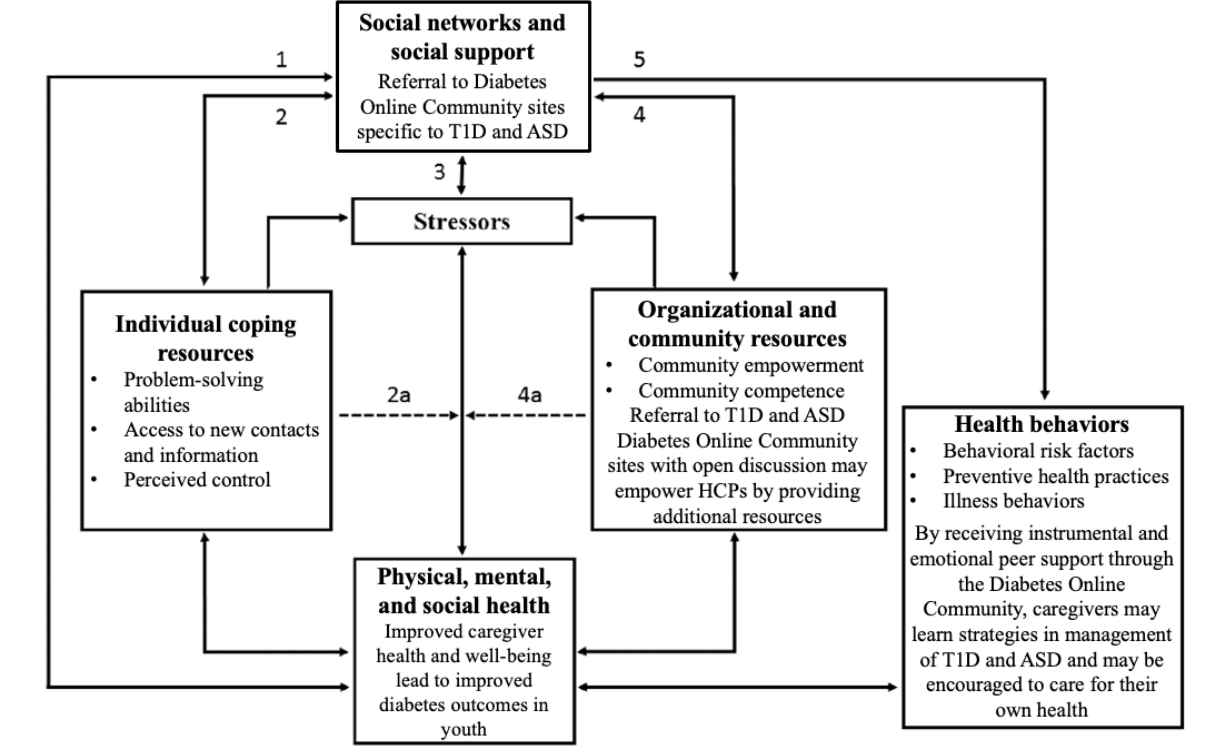
Figure 1. A modified conceptual model for the relationship of social networks and social support to health, specific to type 1 diabetes and autism spectrum disorder. ASD: autism spectrum disorder; HCP: health care practitioner; T1D: type 1